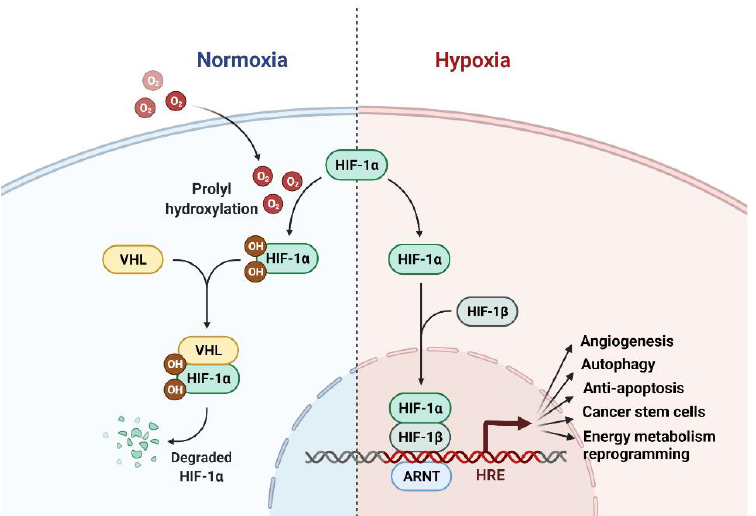
Figure 6. Overview of the hypoxia-inducible factor 1 (HIF-1) signaling pathway under